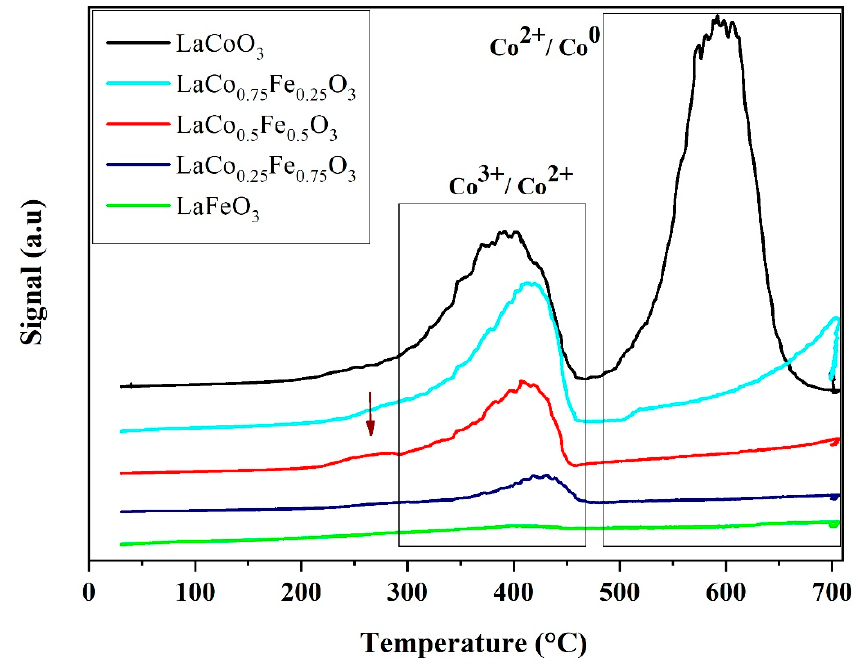
Figure 4. TPR curves of the perovskites.